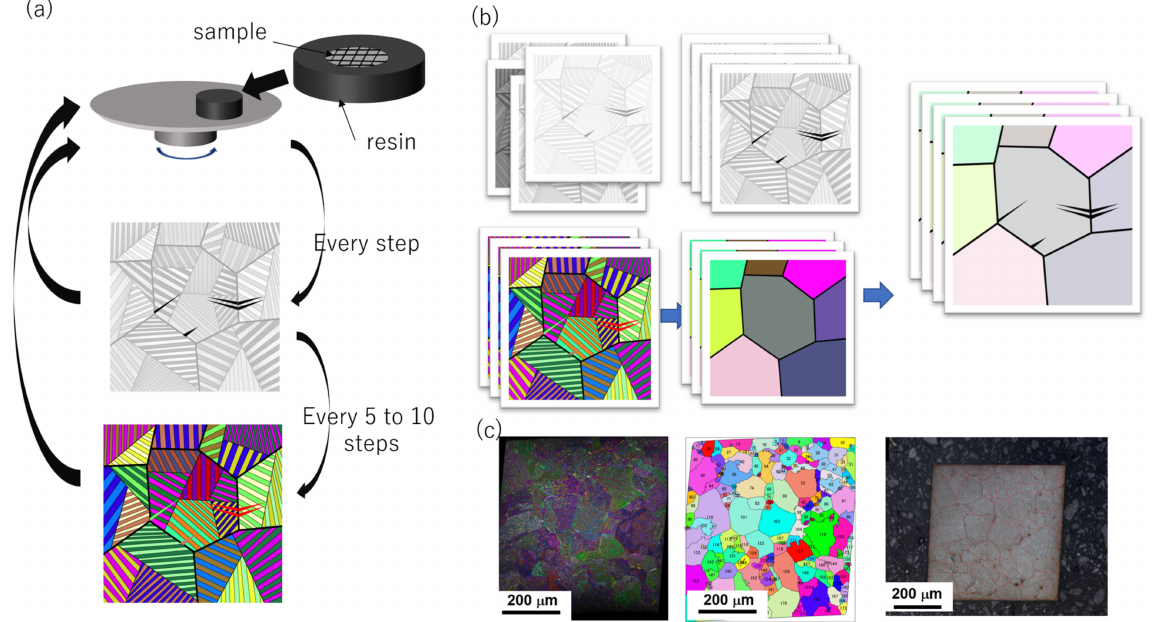
Figure 1. The schematic of the three-dimensional observation procedures. ( a ) The schematic of serial sectioning. ( b ) The schematic of the image processing. ( c ) The IPF map of bainitic ferrites (BFs) and martensite, the IPF map of reconstructed prior austenite grains (PAGs), and the optical microscopy (OM) image with PAGBs drawn by red lines.